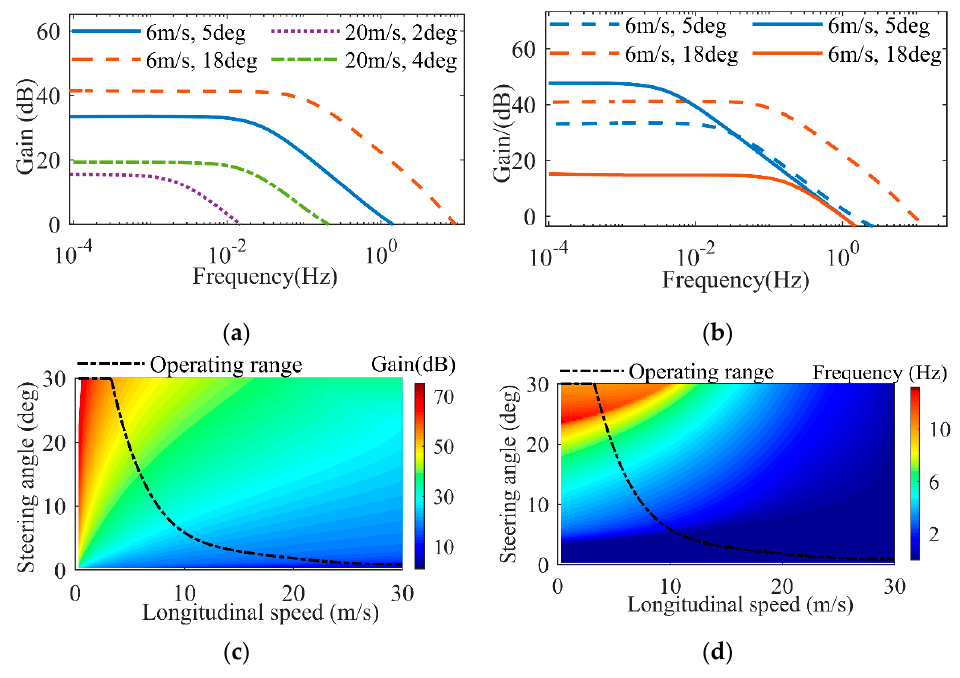
Figure 7. Coupling analysis results of 𝛿 (cid:3033) and 𝐹 (cid:3021) on the vehicle longitudinal dynamics: ( a ) ampli- tude-frequency characteristics from 𝛿 (cid:3033) to 𝑣 (cid:3051) ; ( b ) amplitude-frequency characteristics from 𝛿 (cid:3033) to frequency characteristics from δ f to v x ; ( b ) amplitude-frequency characteristics from δ f to v x and F T 𝑣 (cid:3051) and 𝐹 (cid:3021) to 𝑣 (cid:3051) ( c ) open-loop gains from 𝛿 (cid:3033) to 𝑣 (cid:3051) ; ( d ) cut-off frequencies from 𝛿 (cid:3033) to 𝑣 (cid:3051) . to v x ( c ) open-loop gains from δ f to v x ; ( d ) cut-off frequencies from δ f to v x